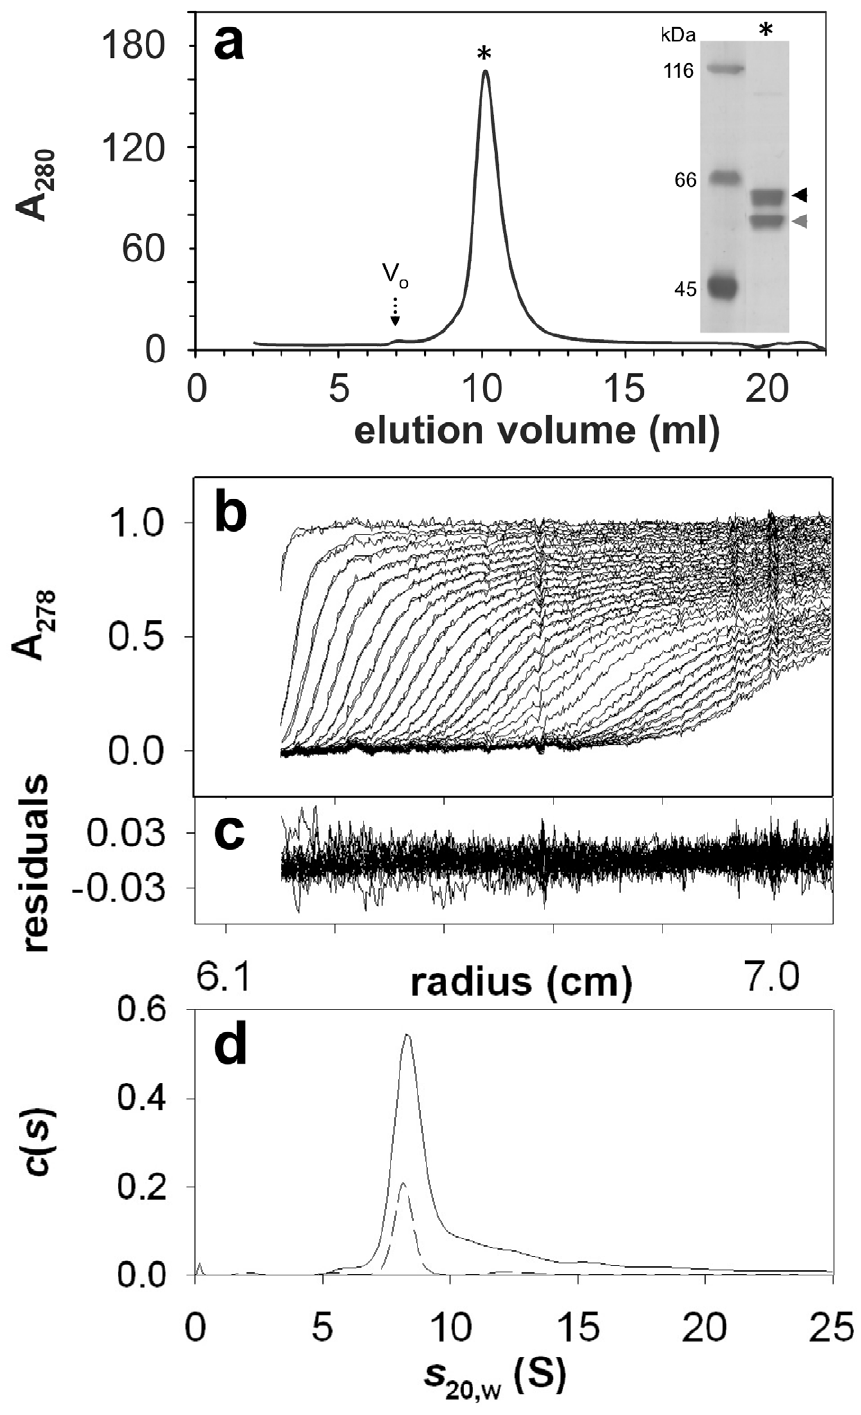
Figure 2. DDM-purified BmrC/BmrD is monodisperse. ( a ) Size-exclusion chromatography of DDM-purified protein ( , 0.3 mg) was performed as indicated in fig. 1 d . Inset: Silver-stained SDS-PAGE of protein eluted at 10 ml. Black arrowhead, BmrD; grey arrowhead, BmrC. V o : void volume. ( b–d ) Samples of nickel-affinity purified BmrC/BmrD (0.85 mg/ml) kept frozen at 2 80 u C after flash freezing in liquid N 2 , were thawed and analyzed by sedimentation velocity measurements at 20 u C and 42000 revolutions per minutes. ( b ) Superposition of selected sedimentation profiles obtained at 278 nm and the corresponding fitted curves using continuous size distribution analysis. ( c ) Superposition of the residuals. ( d ) c ( s ) curves for the stock protein (continuous line) and the protein diluted 4 times in dialysis buffer (dashed line).